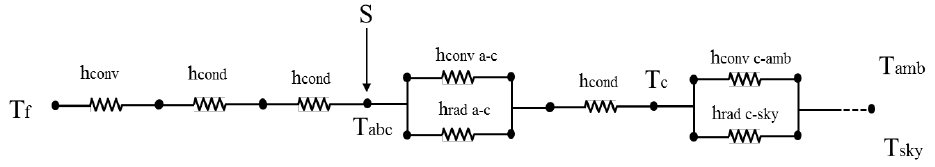
Figure 4. Heat transfer network of CPC solar collectors.